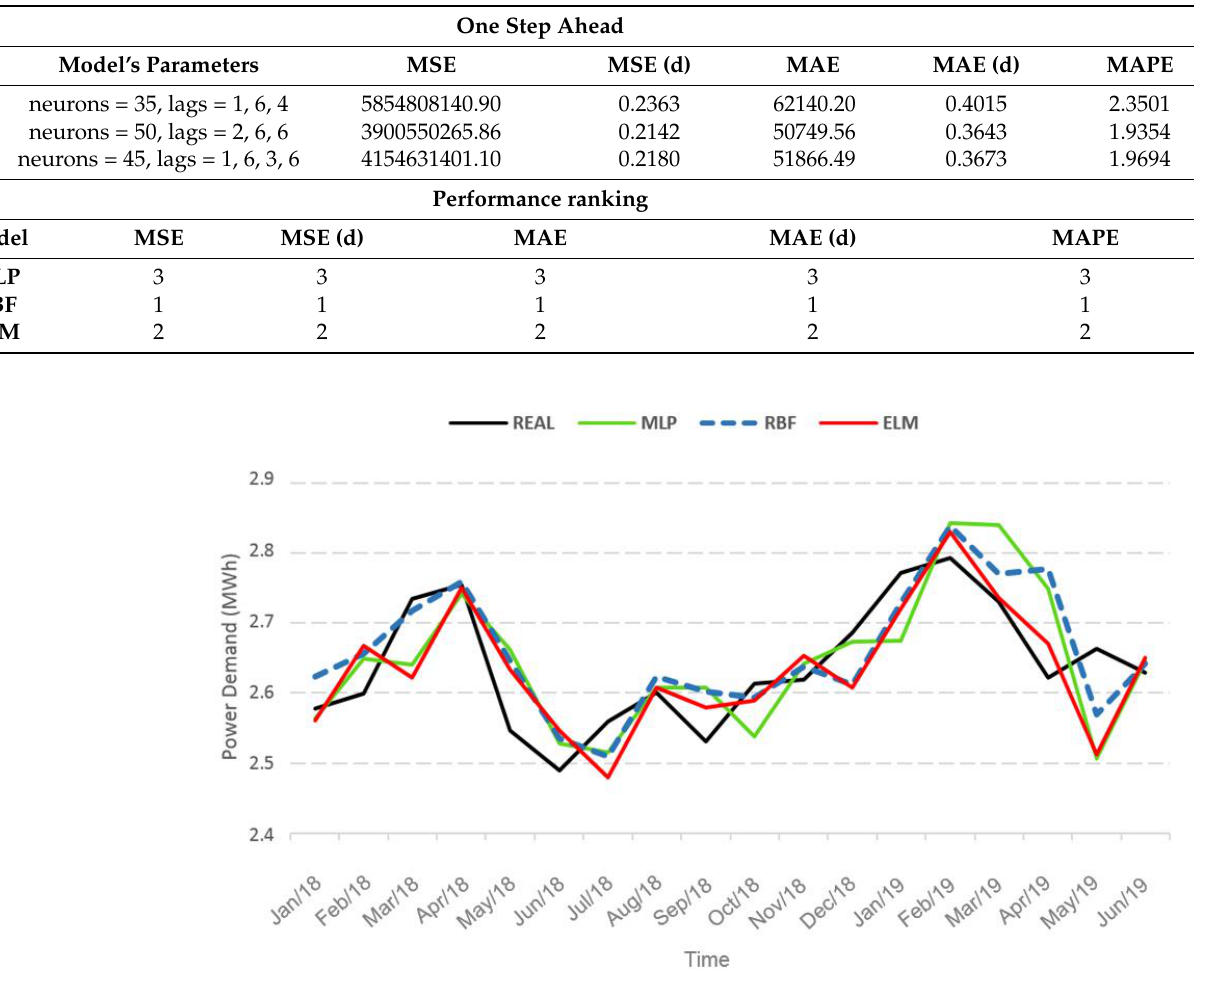
Figure 9. Graph comparing actual data with data predicted for one step ahead, using MLP, RBF, and